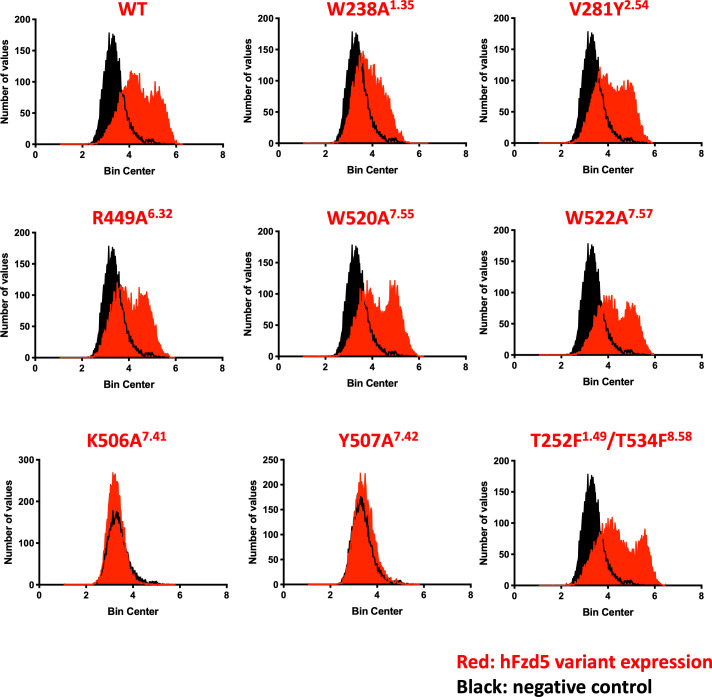
Confirmation of hFzd5 receptor expression in HEK293T transfected cells.Cell-surface hFzd5 variants were fluorescently labeled, and frequency distribution of FACS data are presented for each variant (red) with a negative control (black).Figure 2—figure supplement 1—source data 1.Raw FACS histogram data for Figure 2—figure supplement 1 showing cell-surface expression of hFzd5 variants.